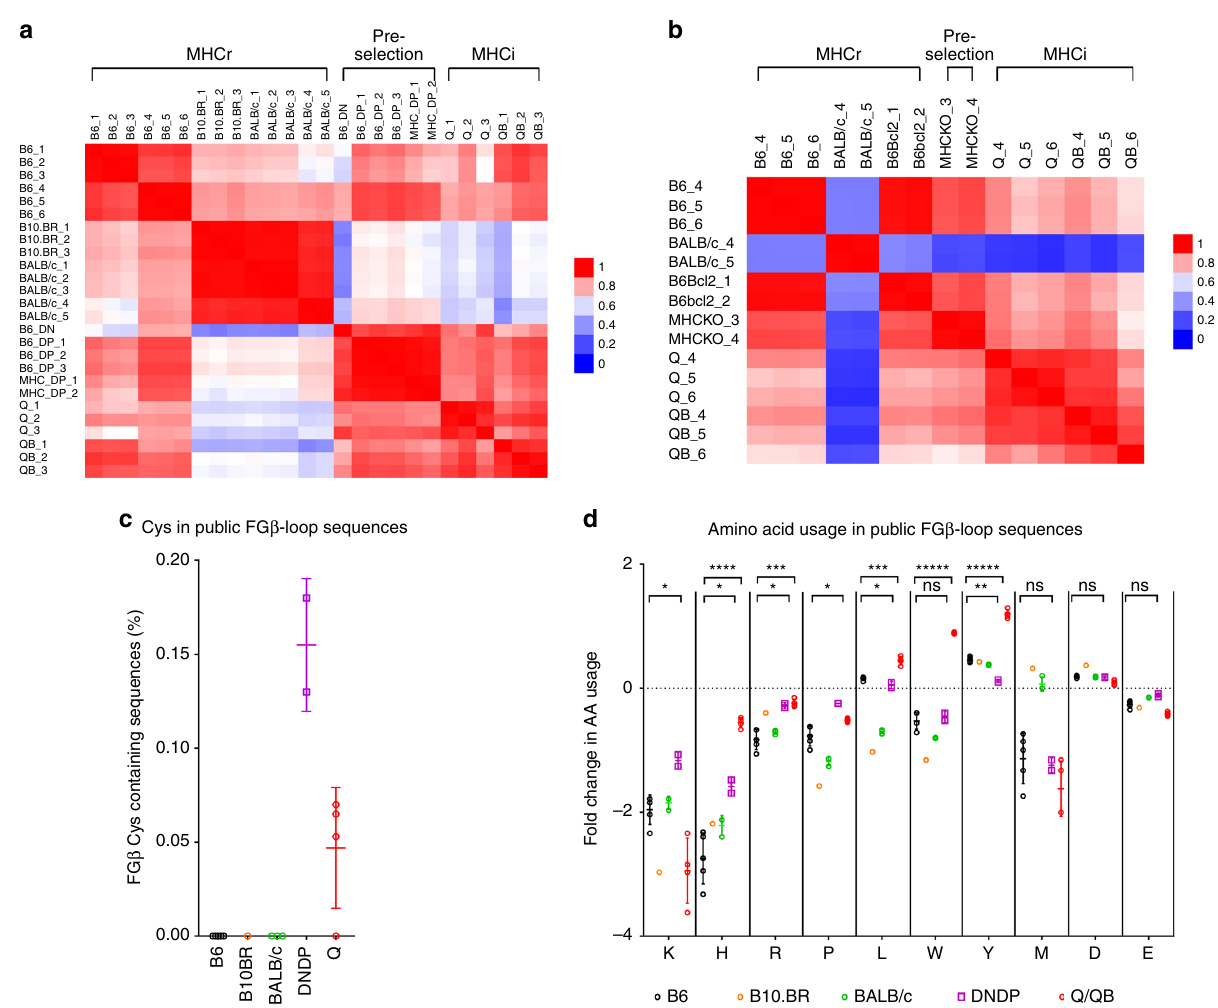
Fig. 7 V-gene usage comparison and the usage of common sequences. a , b Pair-wise Pearson correlation coef fi cients were calculated using V β -gene ( a ) and V α -gene ( b ) frequencies and displayed as heatmaps for MHCi, MHCr and pre-selection TCR repertoires. The sequences of V β - and V α -genes were from Adaptive Biotechnology and Irepertoire, respectively. c , d Cys and other amino acid usages of CDR3 β FG-loop among public sequences from MHCr or MHCi repertoires. The fold change is calculated with respect to those present in B6_DN repertoire. The public sequences of Q and QB are analyzed